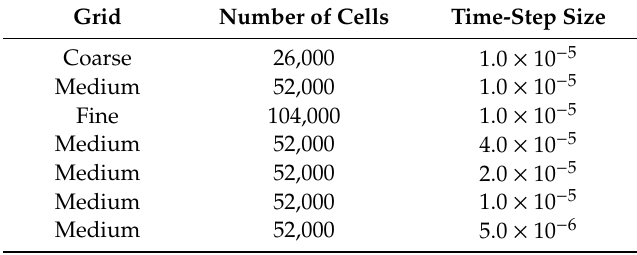
Table 3. Grid refinement and time-step sensitivity test.